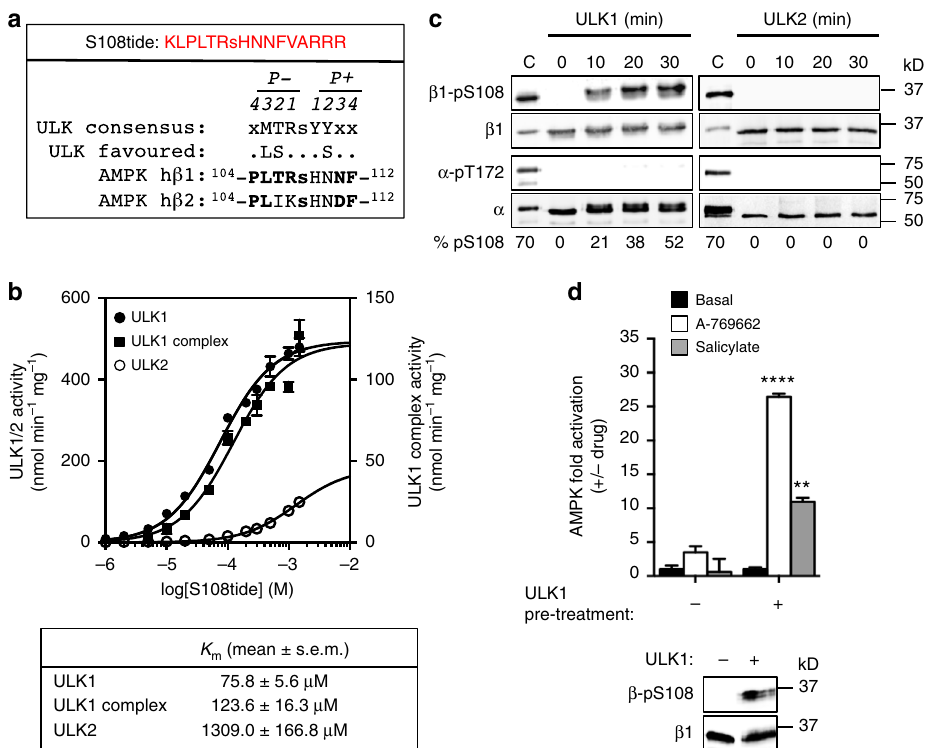
Fig. 4 ULK1 phosphorylates β 1-Ser108 in vitro. a Sequence alignment of the ULK consensus motif/favorable substitutions 23 with human AMPK β 1- and β 2-residues 104 – 112 (Ser108 in lower case). x denotes positions with no demonstrated preference. Preferred/favored consensus β -residues are in bold . Sequence of the synthetic peptide S108tide is shown in red . b Dose curve of S108tide phosphorylation by ULK1 and ULK2 (plotted to left y -axis), and ULK1/ FIP200/Atg13 complex (plotted to right y -axis). n = 3. Error bars , mean activity ± s.e.m. c Immunoblots for β 1-pSer108 and α -pThr172 in bacterial-expressed KI- α 1 β 1 γ 1 phosphorylated with ULK1 ( left ) or ULK2 ( right ) for 30 min. n = 3, representative immunoblots shown. C: CaMKK2-treated α 1 β 1 γ 1 control. d Activity of ULK1-phosphorylated α 1(C176S) β 1 γ 1 in the presence of 20 μ M A-769662 or 10 mM salicylate. n = 3, representative immunoblots of pSer108 in assayed AMPK preparations are shown. Error bars , mean fold AMPK activation relative to ULK1-untreated ± s.e.m. Statistical analyses were performed using one way ANOVA with post hoc Dunnett ’ s multiple comparison test. ** P < 0.01, **** P < 0.0001 indicate signi fi cant increase in AMPK